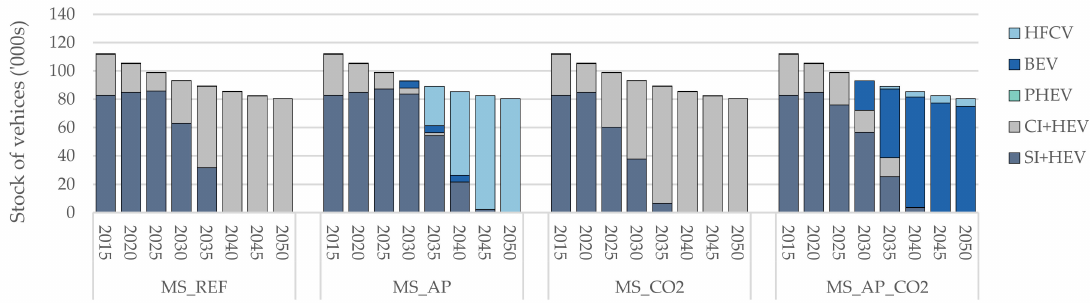
Figure A3. Total stock of cars and light commercial vehicles (LCVs) in the mode shift (MS) scenarios (‘000s). Note : HFCV = hydrogen fuel cell vehicle; BEV = battery electric vehicle; PHEV = plug-in hybrid electric vehicle; CI + HEV = Conventional + non-plug-in hybrid electric compression ignition (CI) vehicle; SI + HEV = Conventional + non-plug-in hybrid electric spark ignition (SI) vehicle.